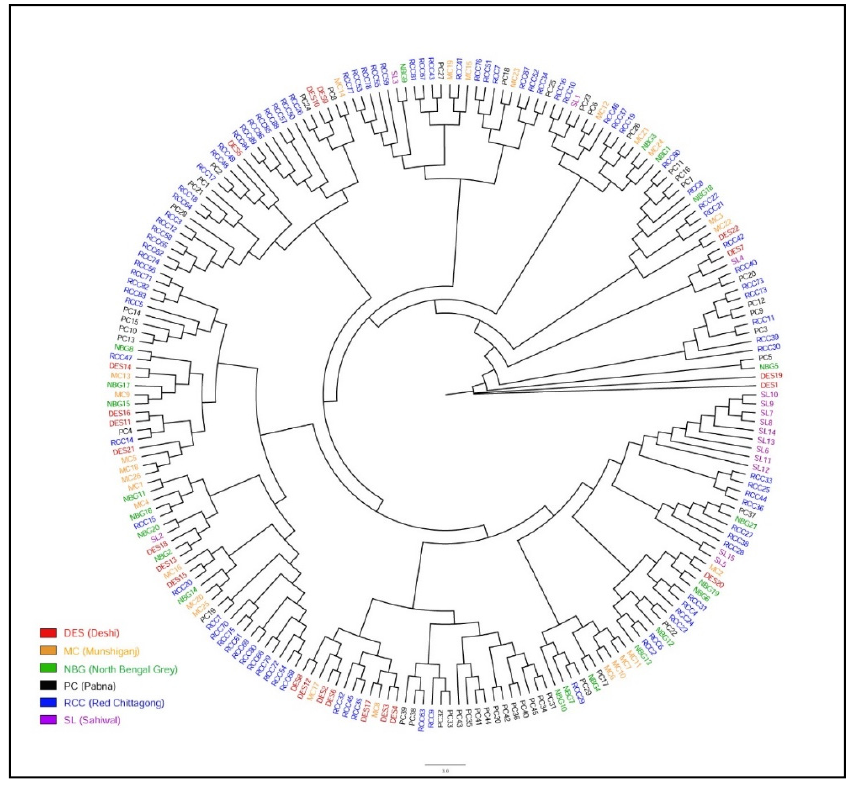
Figure 5. Maximum likelihood phylogenetic tree using six Bangladeshi cattle populations are Sahiwal (SL), Munshiganj (MC), Non-descript Deshi (DES), North Bengal Grey (NBG), Pabna (PC), and Red Chittagong (RCC).